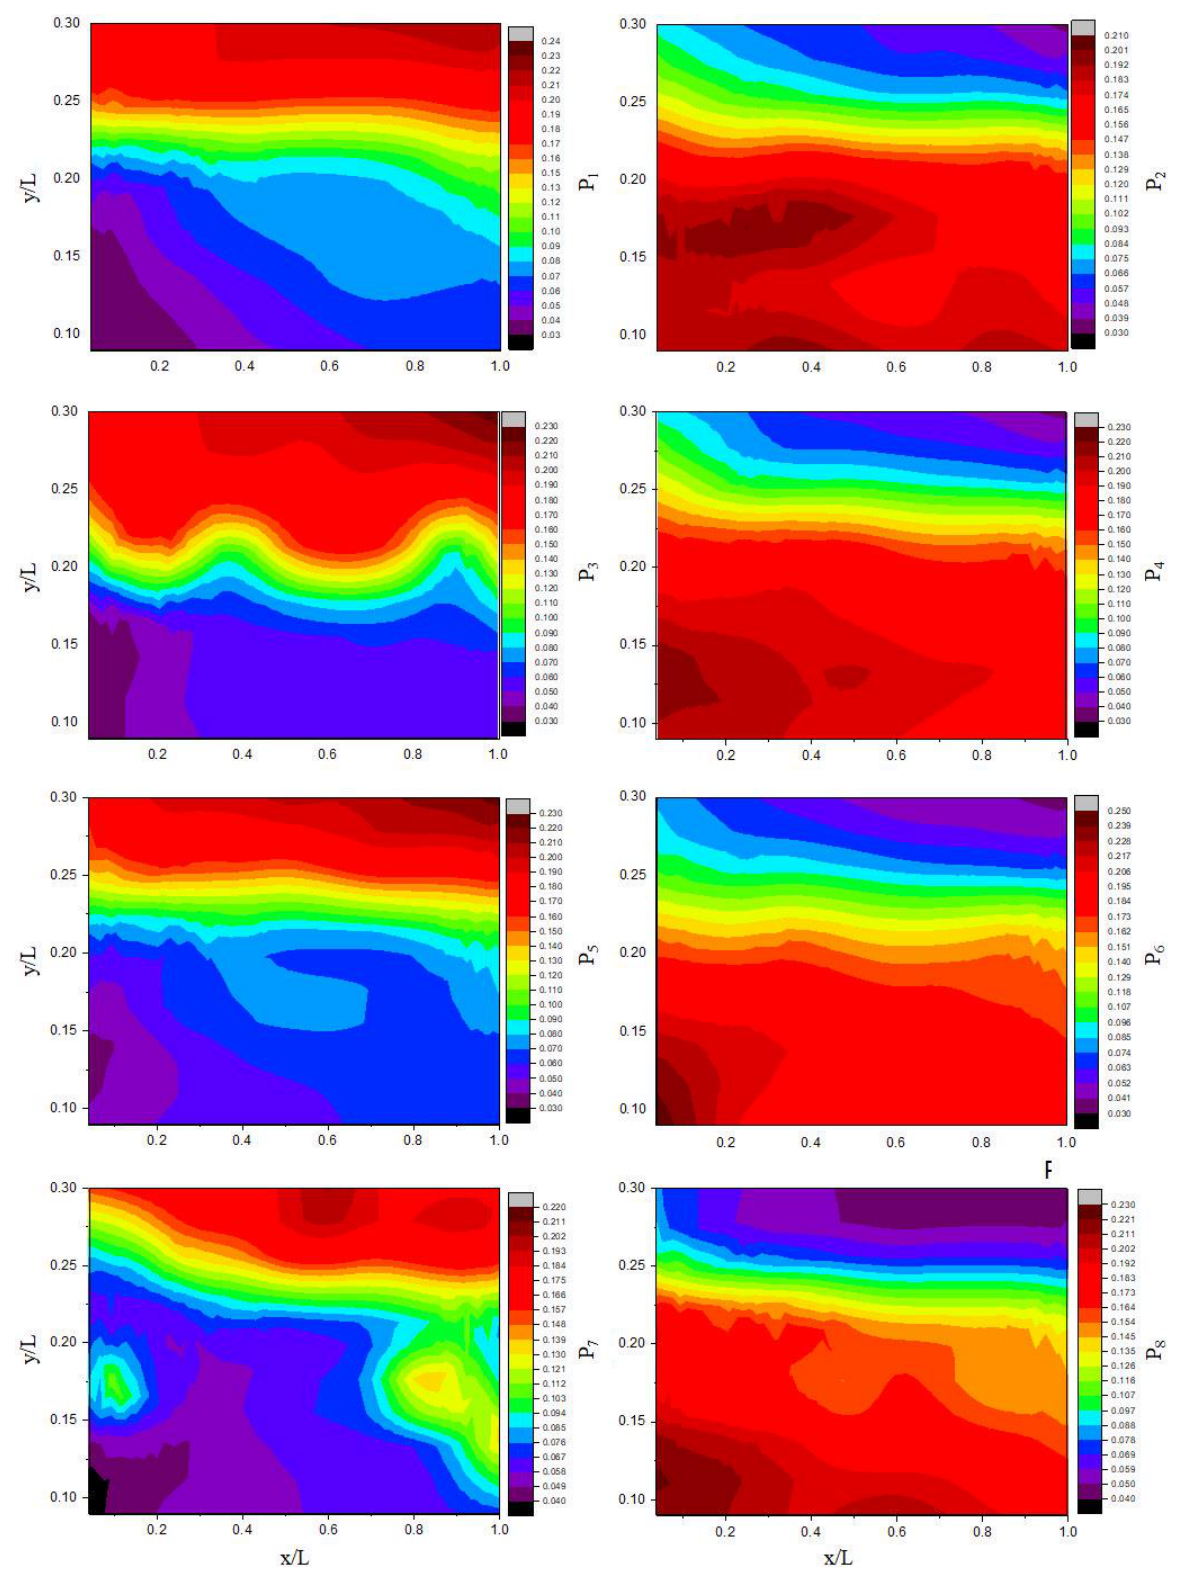
Figure 9. Contours maps of depth-averaged occurrence probability of octagonal bursting events (P 1 –P 8 ) for the experimental run 4R.